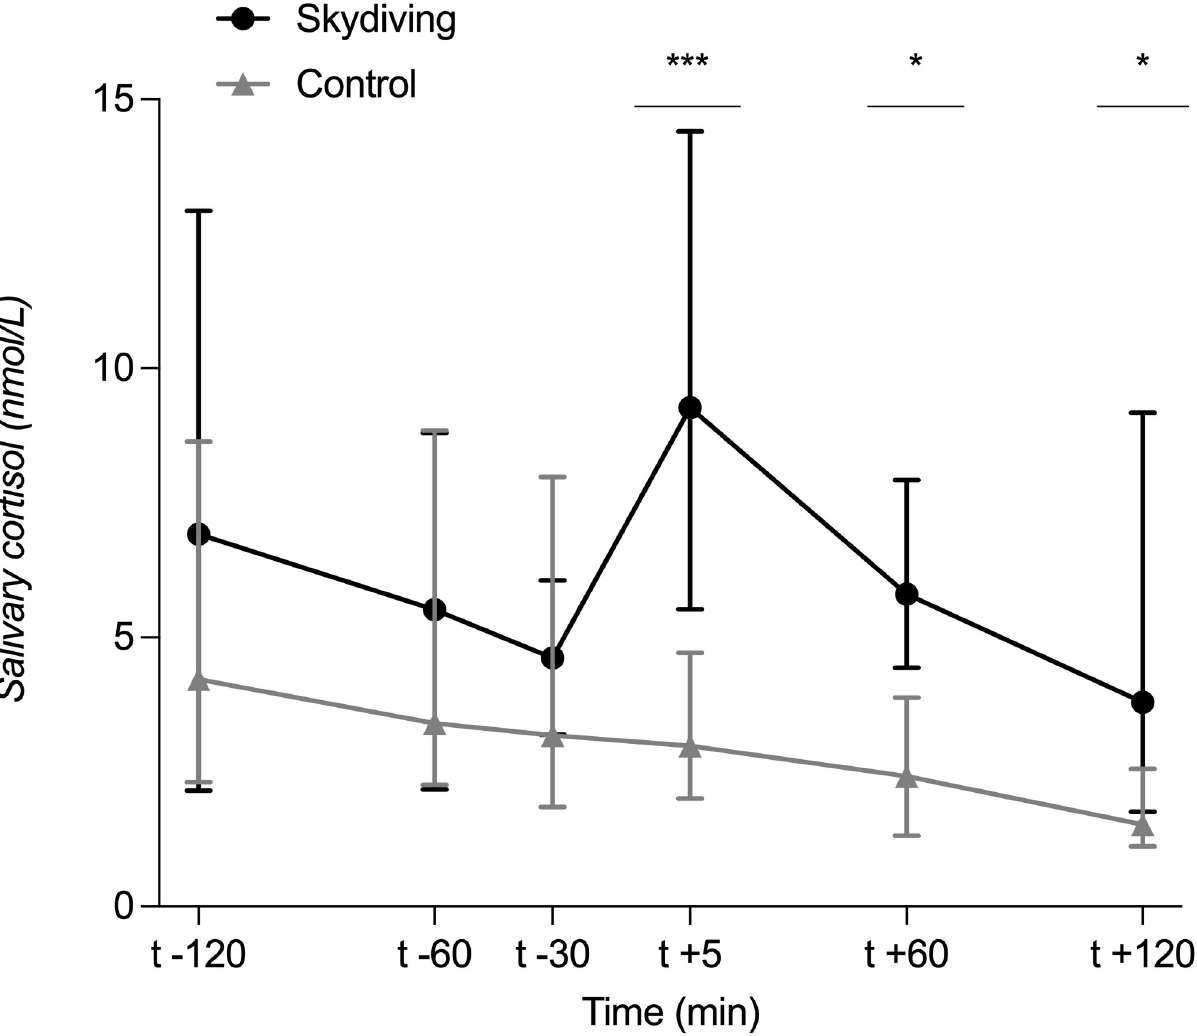
Fig 1. Salivary cortisol concentrations during the test conditions. Median and IQR are shown. p-values indicate significant differences between the two conditions. � p < 0.05 (two hours after the skydive). � p < 0.05 (one hour after the skydive). ��� p < 0.001 (directly after landing). nmol/l; skydiving: 4.5 nmol/l, 2.9–6.7 nmol/l; p = 0.17). Directly after landing (t cortisol concentrations were significantly increased in comparison to the control condition (control: 2.9 nmol/l, 2.0–4.7 nmol/l; skydiving: 9.2 nmol/l, 4.7–14.3 nmol/l; p < 0.001). Salivary cortisol levels after skydiving were still significantly increased one hour (t nmol/l, 1.3–3.9 nmol/L; skydiving: 5.8 nmol/l, 4.4–7.9 nmol/l; p < 0.05) and two hours after landing (t ) (control: 1.7 nmol/l, 1.1–2.7 nmol/l; skydiving: 3.8 nmol/l, 1.8–9.2 nmol/l; +120 p < 0.05), respectively, compared to the control condition.